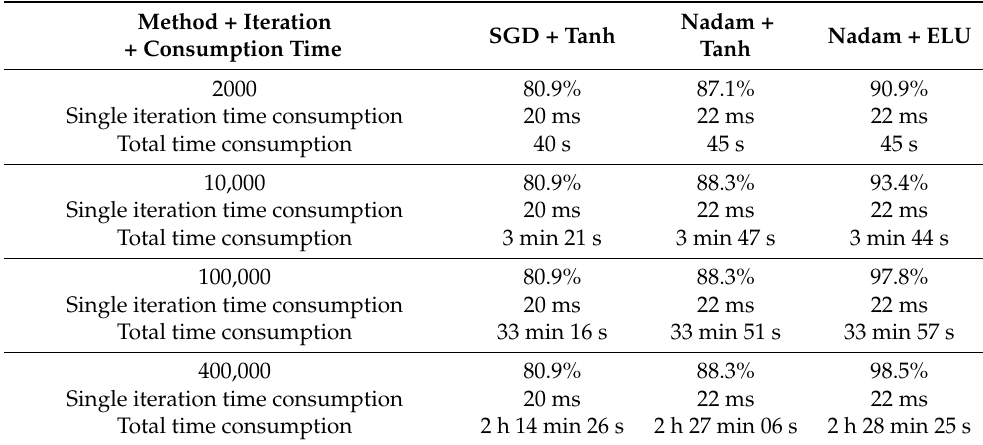
Table 6. The time consumed by different methods during iteration. Method +